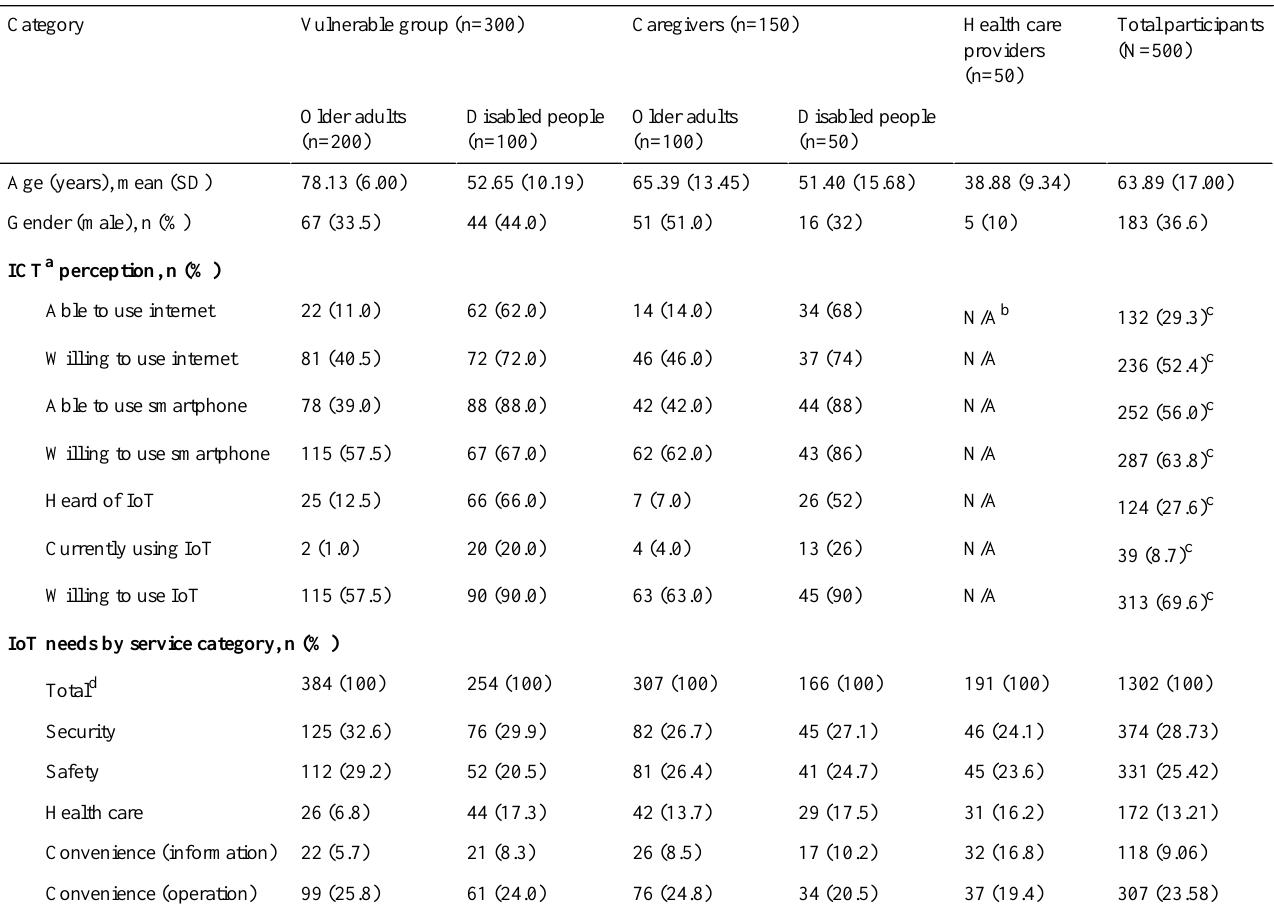
Table 3. Digital literacy and Internet of Things (IoT) needs of the three